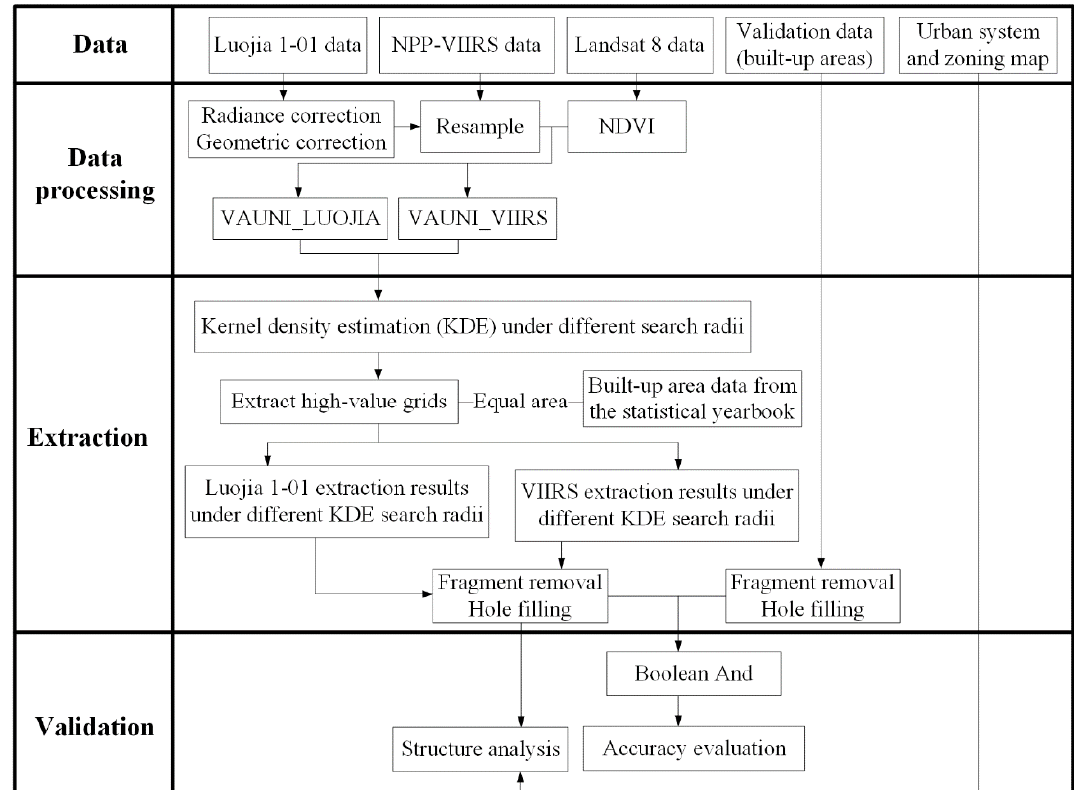
Figure 3. The conceptual diagram of analytical procedure of this study.